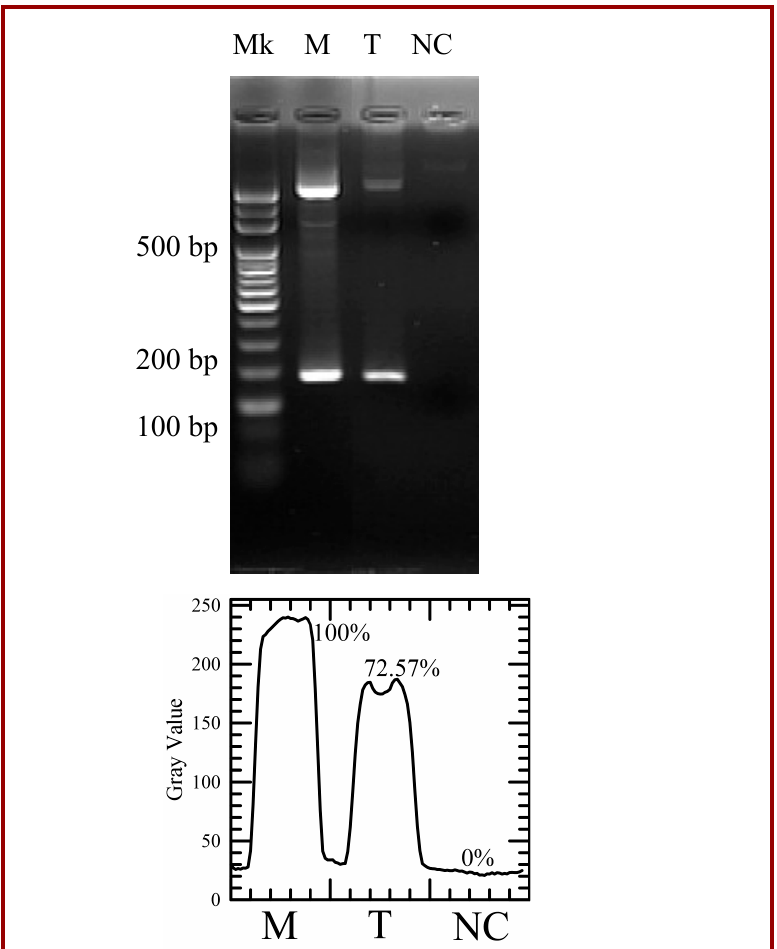
Figure 11. Agarose gel electrophoresis of the polymerase chain reaction (PCR) yield. The first lane (Lane Mk) indicates the DNA ladder. The 190-bp PCR product in the commercial PCR machine (Lane M) and in our device (Lane T). Lane NC indicates a mixture for a negative control. The gray intensities of PCR products are created by image analysis.